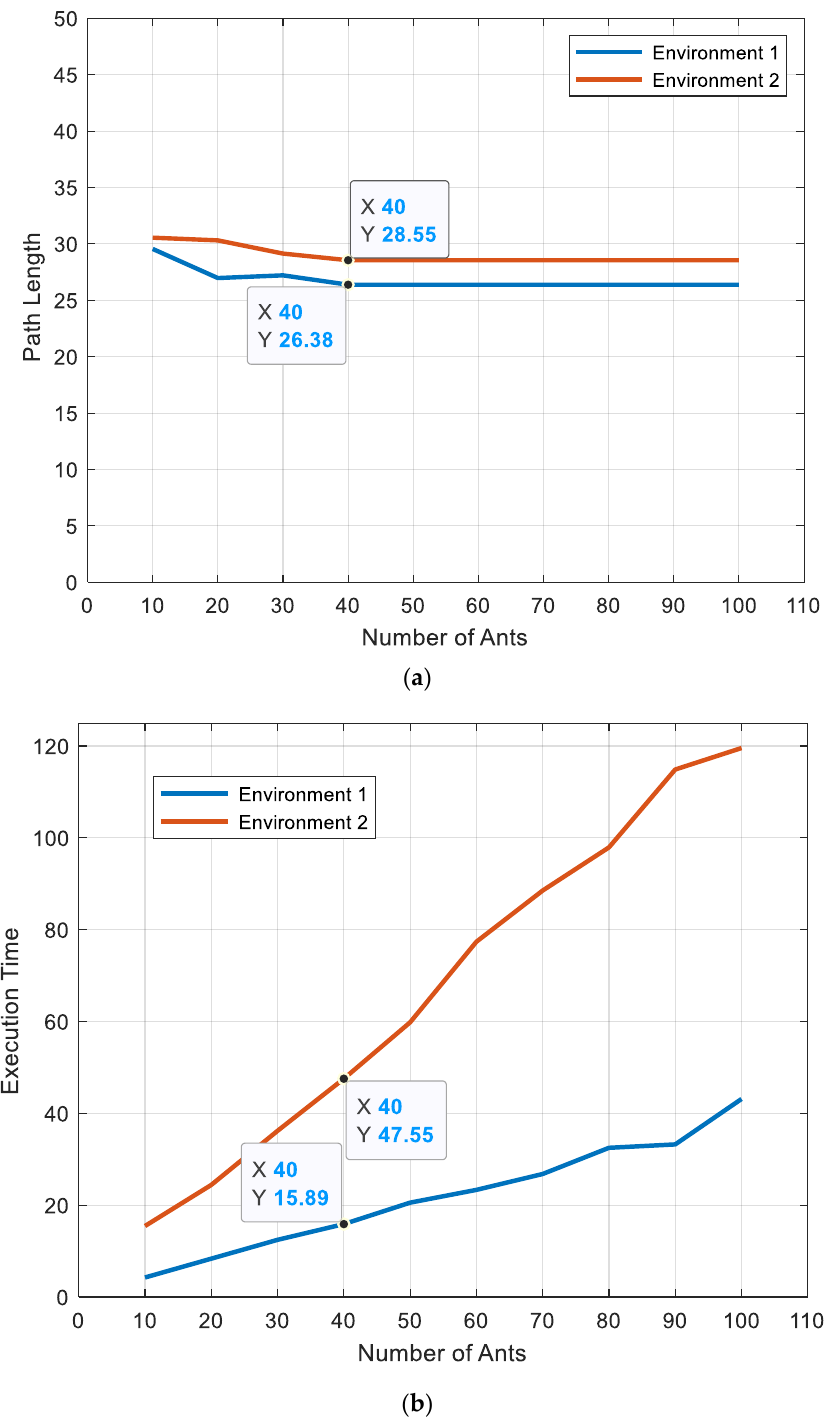
Figure 10. Effect of the number of ants on ( a ) path length and ( b ) execution time for environment 1 and environment 2.